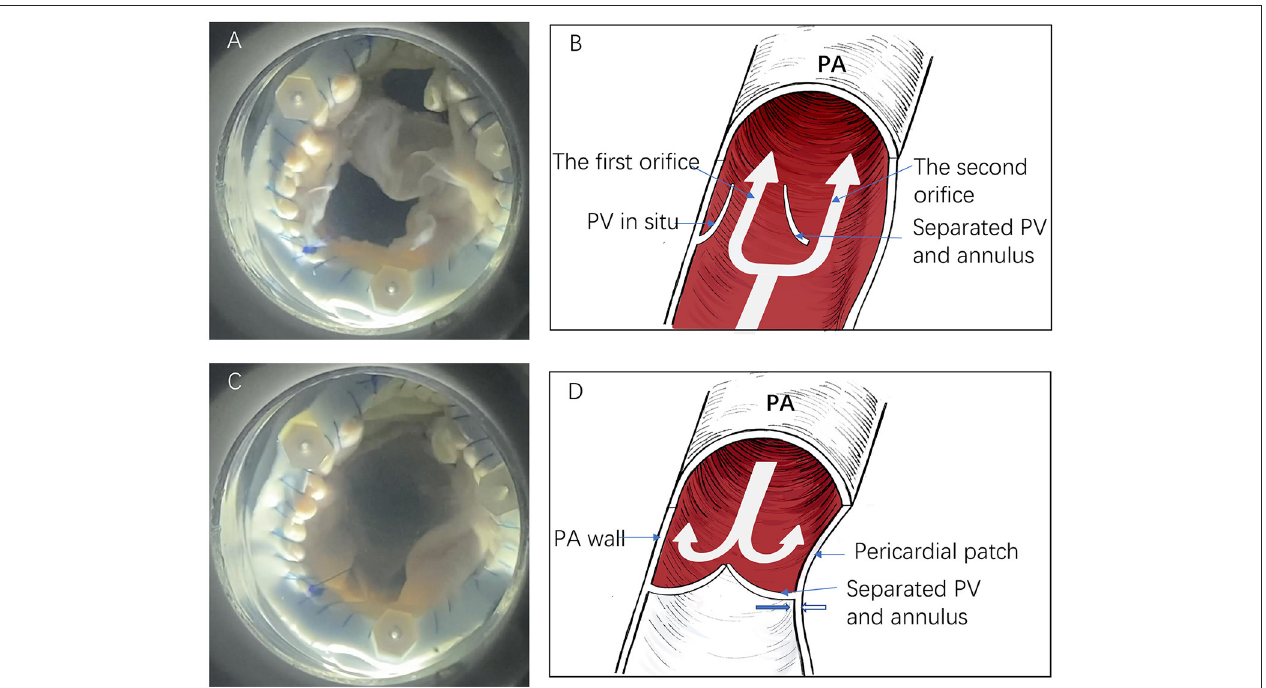
FIGURE 4 | The in vitro simulation test and descriptive figure illustrating anti-regurgitative mechanism. (A,B) The forward blood flow passes via the two orifices during the systole. (C,D) The second orifice closes following a negative pressure effect (Bernoulli effect) from the right ventricle. The thick blue and white arrows indicate the separated pulmonary valve and pericardial patch direction, respectively (PV, pulmonary valve; PA, pulmonary artery).